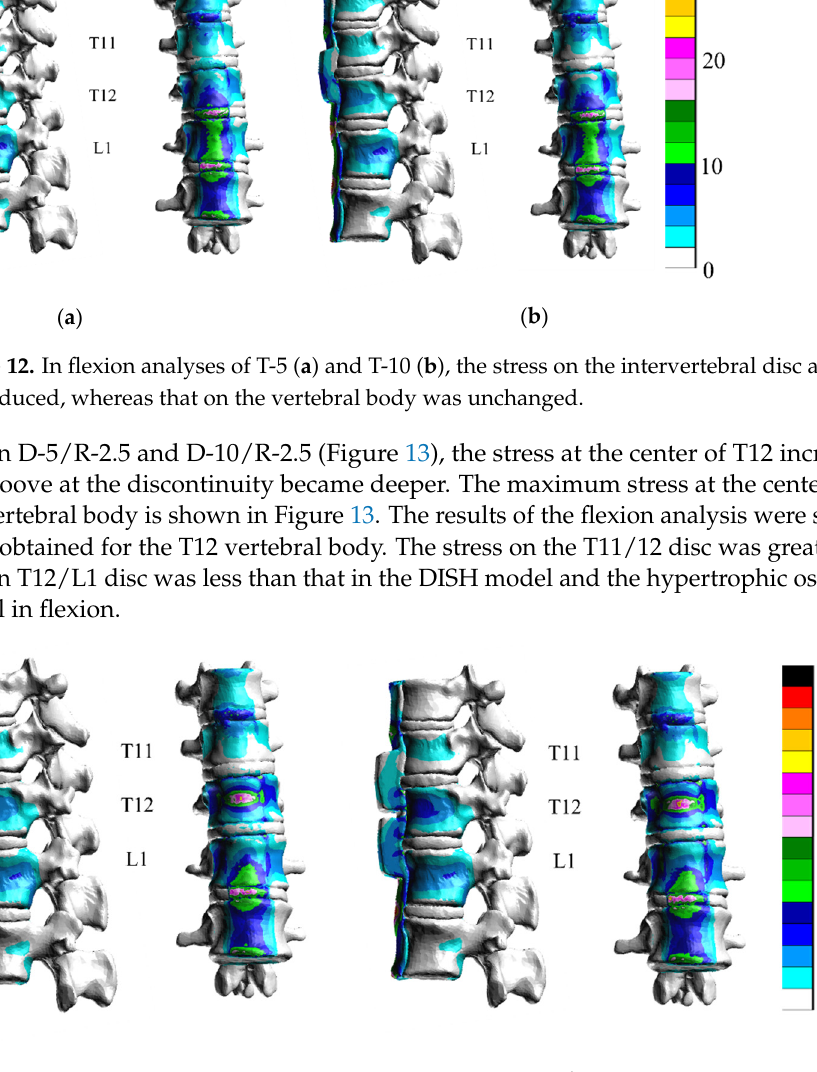
Figure 11. Only vertebral bodies and discs are shown for clarity. The right bar is color-coded ac- cording to stress (MPa). Stress diagrams of ( a ) the healthy model and ( b ) the DISH flat model. Stresses were greater in the flat model in flexion than in the healthy model.